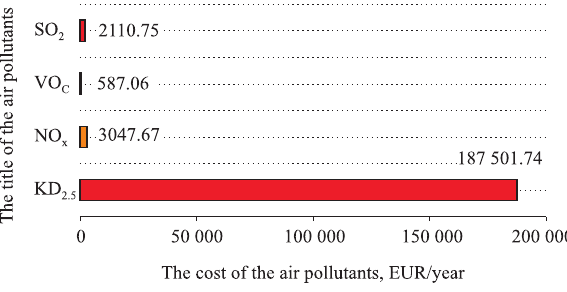
Fig. 6. Th e cost (EUR) of air pollutants within the urban territory (Accumulation and renewal of traffi c data of the roads of national signifi cance,